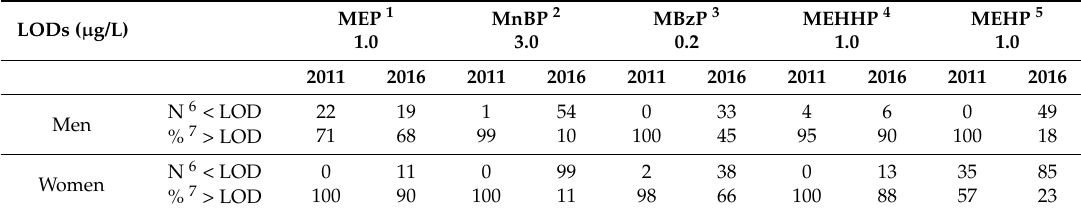
Table 4. Limits of Detection (LOD) and detection